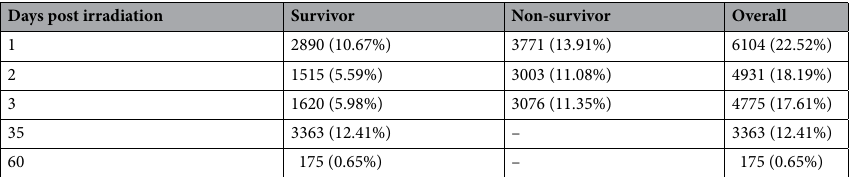
Table 1. Differentially expressed genes at each time point for each outcome group. The numbers in parenthesis represent the percentage of those differentially expressed genes that were identified in the database